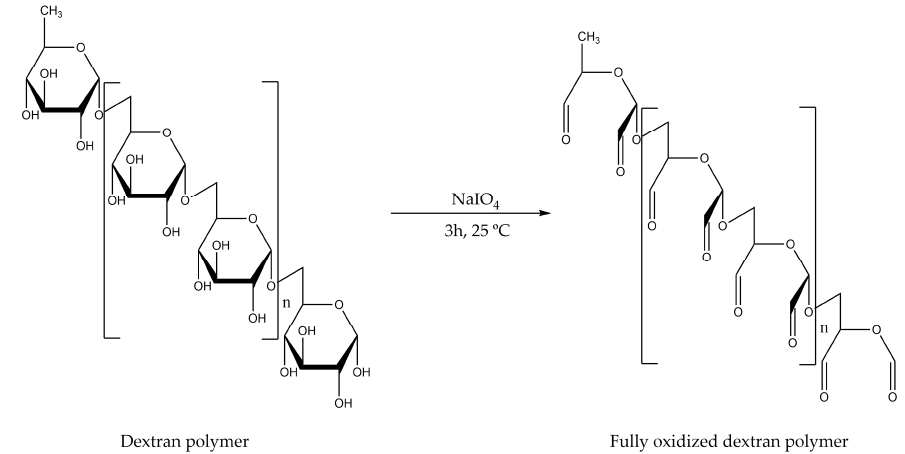
Figure 1. Periodate oxidation of dextran’s α -1,6-glucose residues.